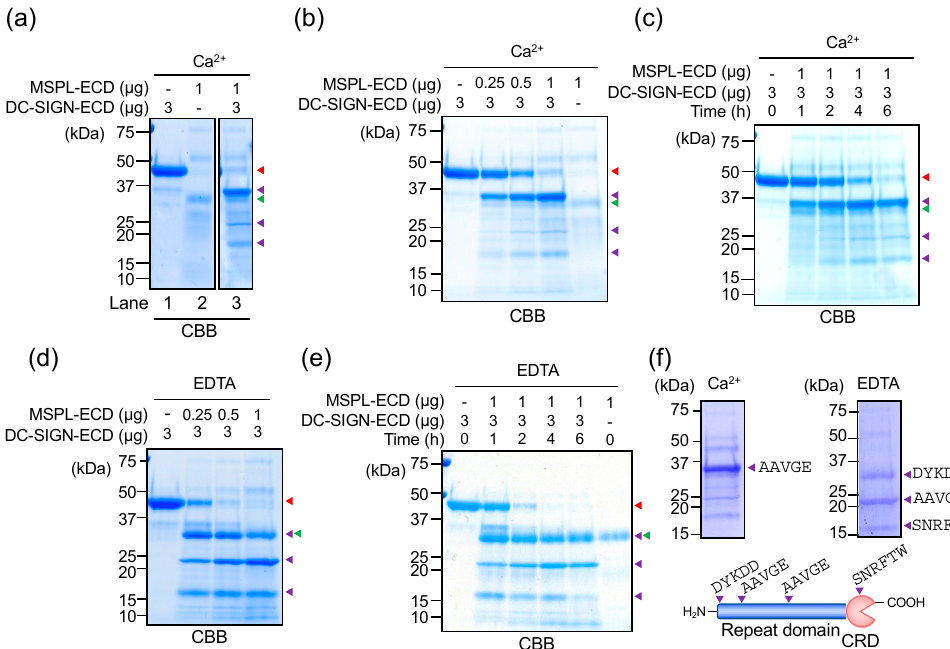
Figure 4. Proteolytic activity of MPSL in the presence of Ca 2 + and EDTA. ( a ) The purified MSPL–ECD and DC-SIGN–ECD were separated via SDS–PAGE under reducing conditions and detected with CBB staining (lanes 1 and 2). The two molecules were co-incubated in the presence of Ca 2 + at 37 ◦ C for 6 h (lane 3). The colored arrowheads indicate bands of full-length (red) and digested DC-SIGN–ECD (purple), and MSPL–ECD (green). ( b – e ) The MSPL–ECD dose- ( b , d ) and time-dependency ( c , e ) of DC-SIGN degradation in the presence of Ca 2 + ( b , c ) and EDTA ( d , e ) were tested. ( f ) DC-SIGN–ECD cleavage sites were identified through N-terminal amino acid sequencing (BIOSUMS, Shiga, Japan). The amino acid sequences obtained are shown using one-letter codes. CRD: Carbohydrate recognition